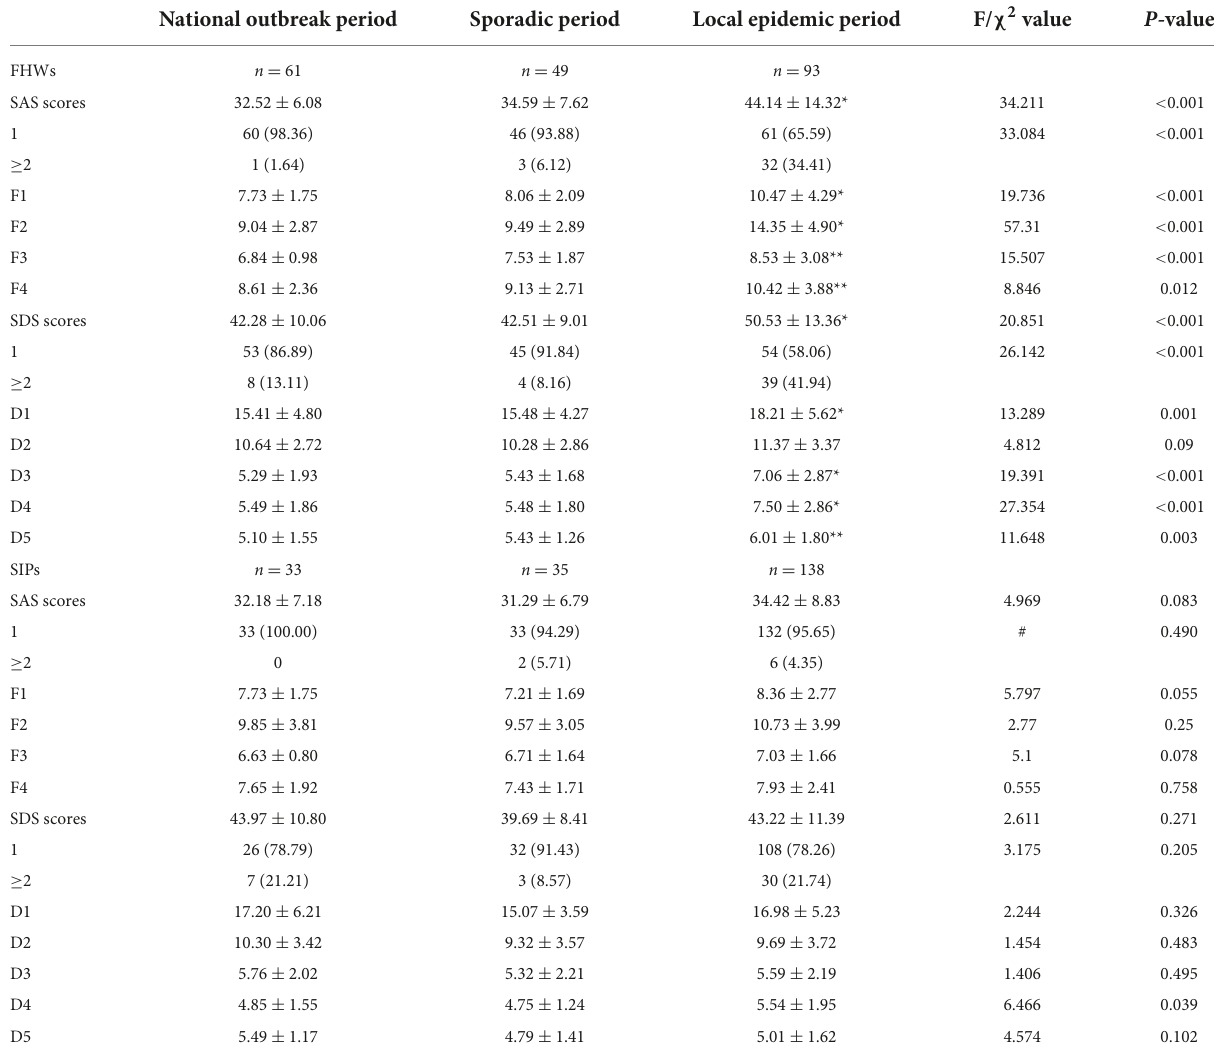
TABLE 2 Depression and anxiety status and scores for the enrolled health care workers and patients.